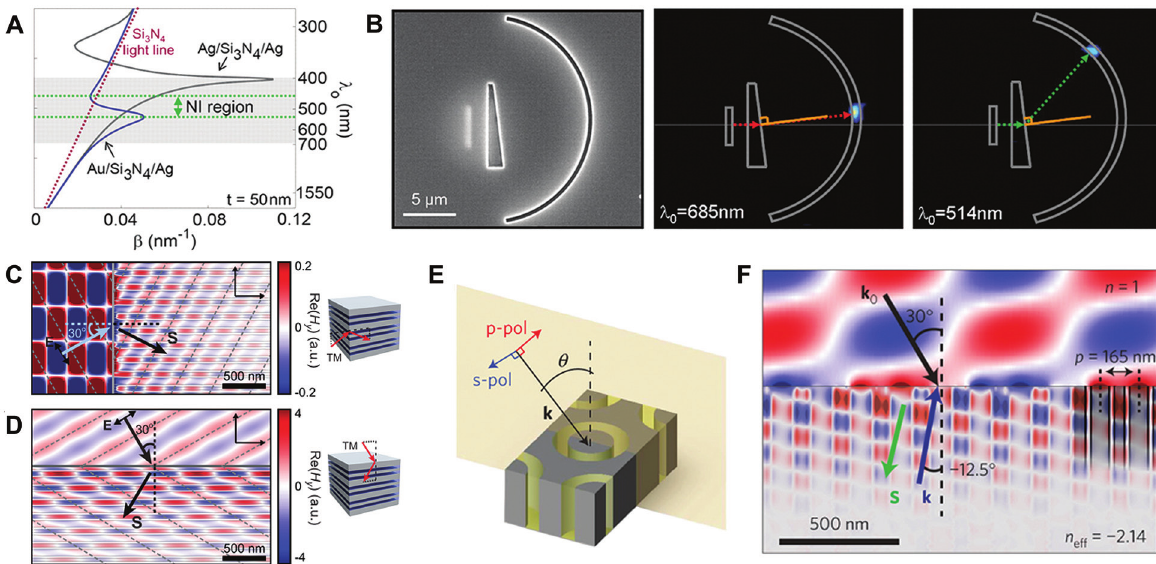
N -Ag and an Au-Si N -Ag waveguide when the thickness of Si N is 50 nm. (B) Left Figure 4 (A) Dispersion curves for SPPs in an Ag-Si 3 4 3 4 3 4 column: scanning electron micrograph image of the fabricated device at the output side. Central and right columns: optical microscope = 685 nm and 514 nm, showing positive refraction and negative refraction of SPPs, respectively. (C) and (D) Field image for illumination at λ 0 = 400 nm), which is incident from air into a 3D metamaterial made of an plot of the H component showing negative refraction of light ( λ y 0 array of MDM waveguides. The arrows show the unit-cell-averaged direction of the time-averaged Poynting vector. The illuminated interface is normal and parallel to the waveguides in (C) and (D), respectively. Gray dashed lines indicate incident and refracted wavefronts. (E) Unit = 483 nm) at cell of a NIM consisting of a hexagonal array of subwavelength coaxial waveguide structures. (F) Negative refraction of light ( λ 0 the interface between air and a metamaterial made of an array of Ag-GaP-Ag coaxial plasmonic waveguides. The period of the waveguide array is 165 nm, the thickness of the GaP annular channel is 25 nm, and the inner Ag diameter is 75 nm. Shown is a snapshot of the H y component taken in the polarization plane. (A) and (B) are adopted from Ref. [38], (C) and (D) are adopted from Ref. [39], and (E) and (F) are adopted from Ref. [40] with